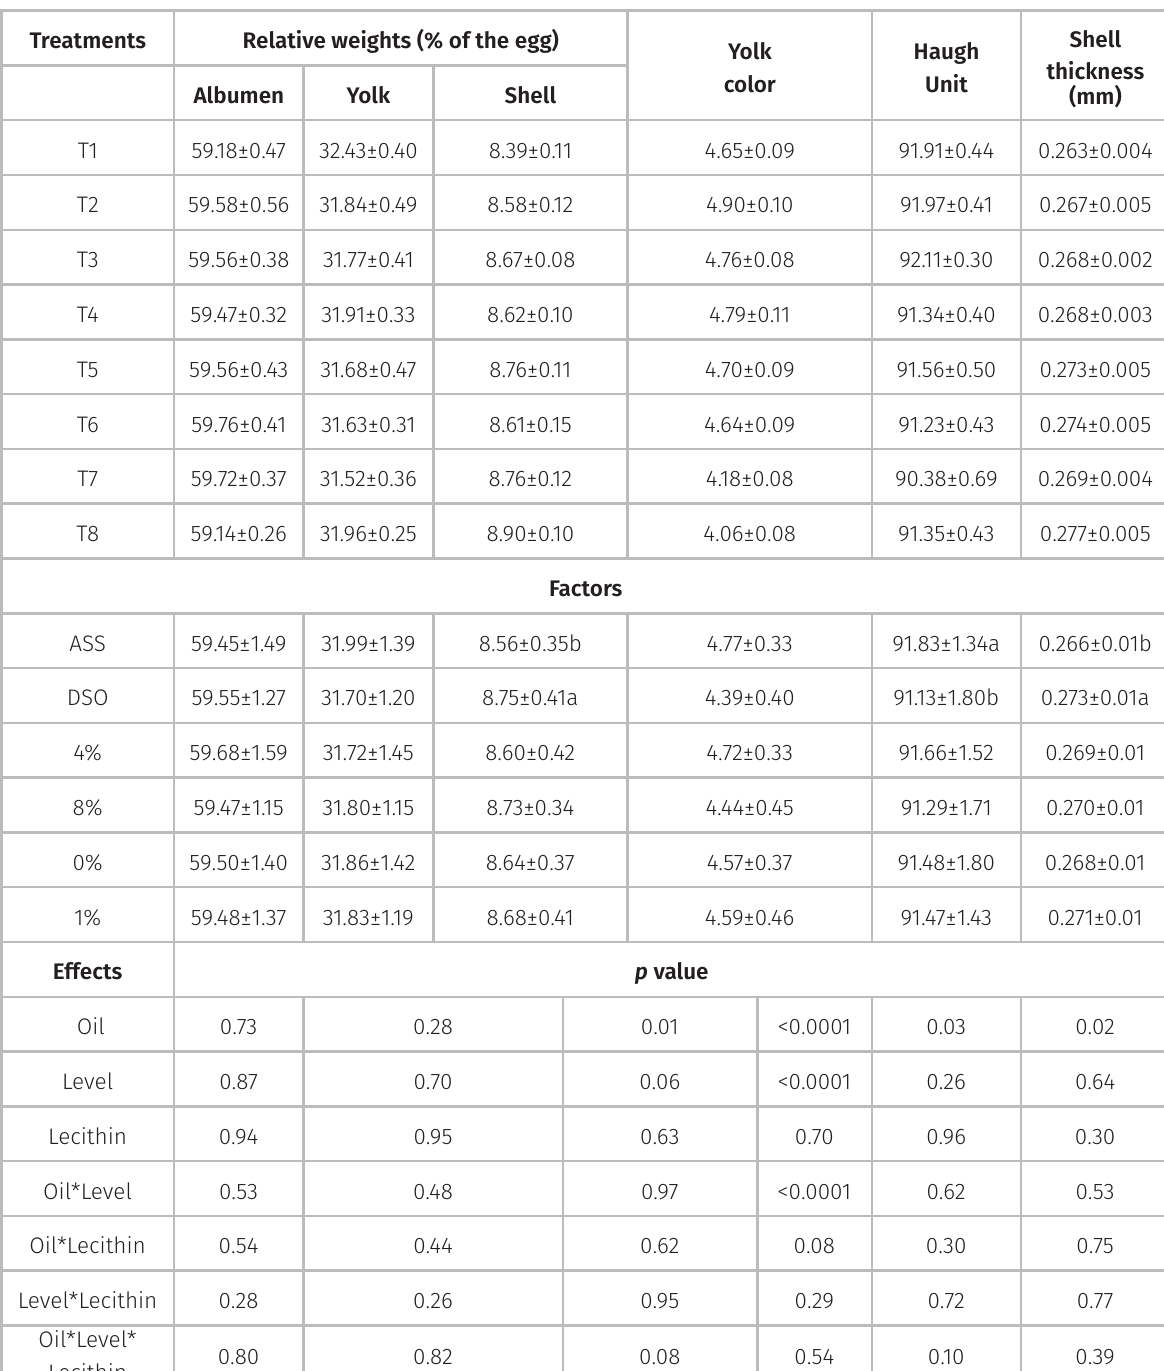
Table III. Influence of acidulated soybean oil (ASS) and lecithin fed to Japanese quails during six productive periods on egg quality (mean ± standard